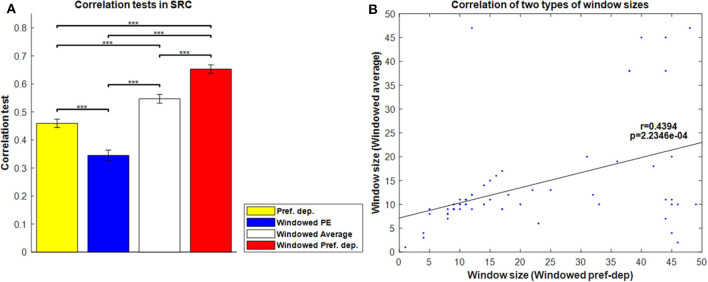
Results on Windowed models. (A) Correlation tests for the sequence-rating-continued-version task with Windowed estimators. For long sequences with length up to 100, the Windowed Preference-dependent estimator produced a 0.6529 correlation, while only 0.4594 was achieved without windowing. P-values of t-test: ***p < 0.001. (B) Plot of the window sizes of the Windowed Average and Preference-dependent estimators. The correlation between them was 0.4394 with p-value 2.2346e-04.